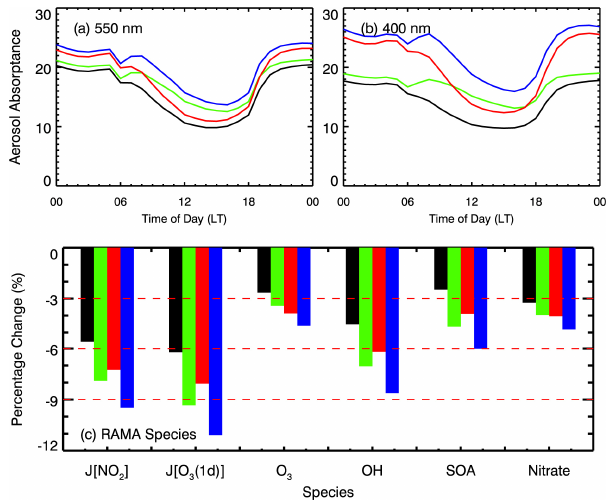
Figure 12 Fig. 12. Daily cycle of the percentage change of aerosol absorbance at (a) 550nm and (b) 400nm averaged over RAMA sites and dur- ing the period from 24 to 29 March 2006 when the aerosol ef- fect on the photolysis frequencies is considered; (c) Percentage change of J [O 3 ( 1 D)], J [NO 2 ], O 3 , OH, SOA, and nitrate due to aerosols averaged over RAMA sites and during the period from 24 to 29 March 2006. Black: without the rapid aging of BC and en- hanced UV-radiation absorption by POA; red, without the rapid ag- ing of BC; green: without the enhanced UV-radiation absorption by POA; blue: the base